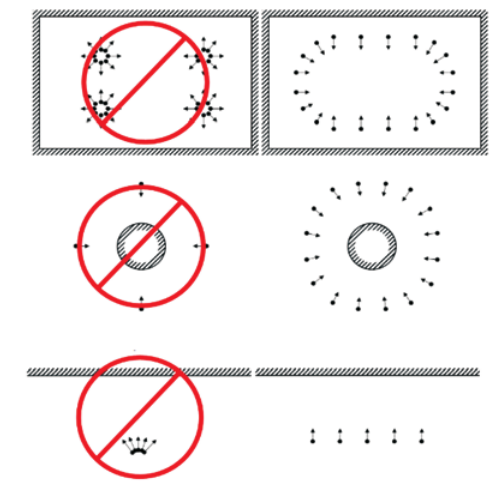
Fig. 4. Ways of shooting source sdata images (Agisoft LLC